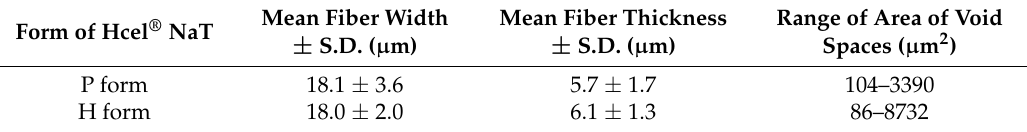
Table 1. Morphological parameters of the P and H forms of Hcel ® NaT.